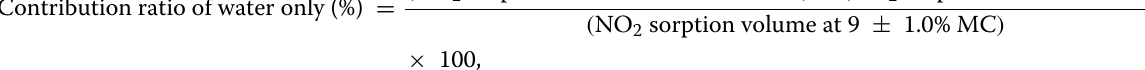
1%. ± 3). *:0.05 > p (Tukey =